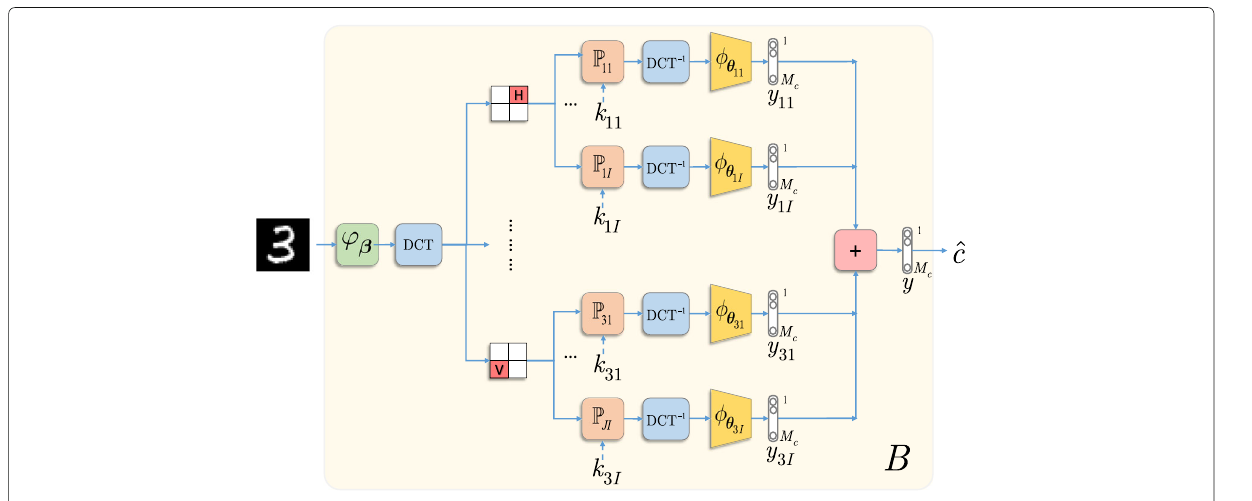
Fig. 9 Multi-channel classification with the local DCT sign